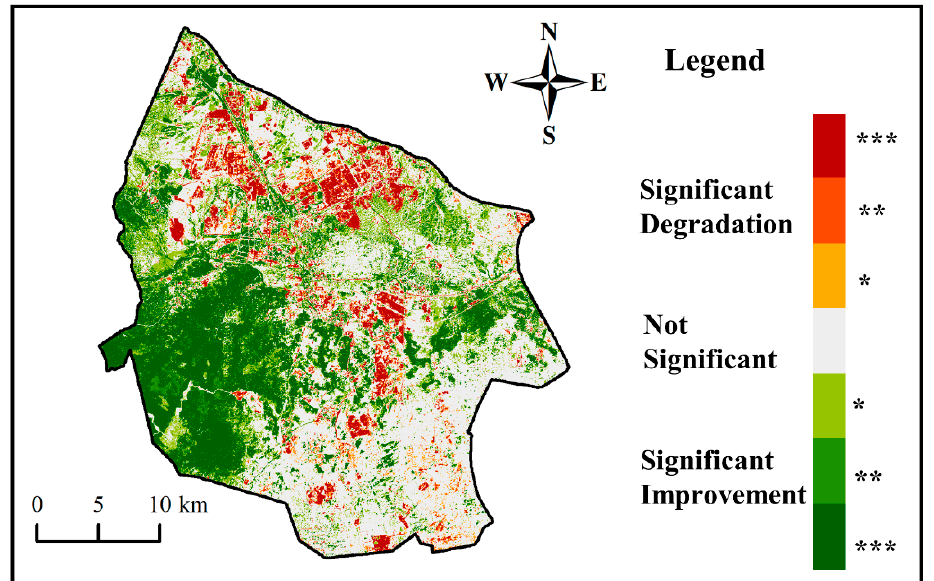
Figure 4. Spatial variation in vegetation fractional coverage (VFC) from 2004 to 2019. Significant at * p < 0.1, ** p < 0.05, and, *** p < 0.01, respectively.